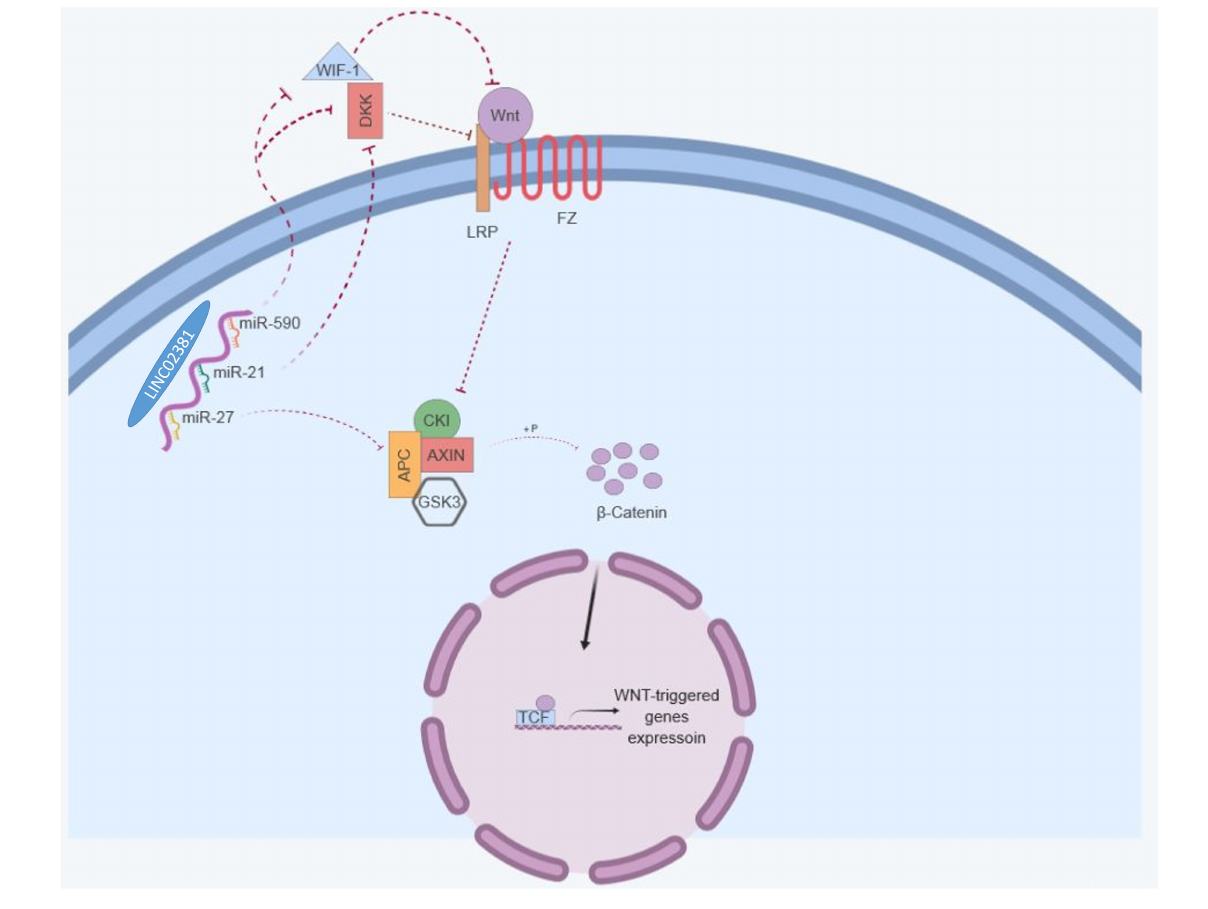
Frontiers in Oncology |